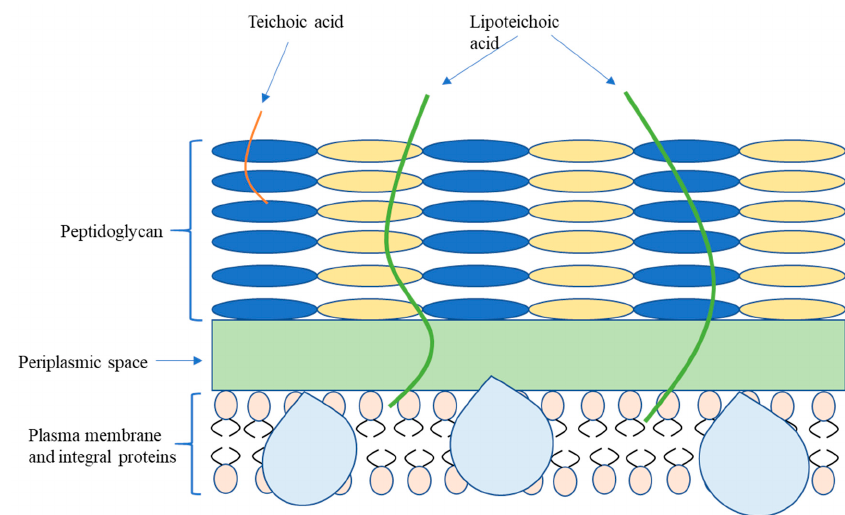
Figure 1. Cell structure of Gram-positive bacteria.